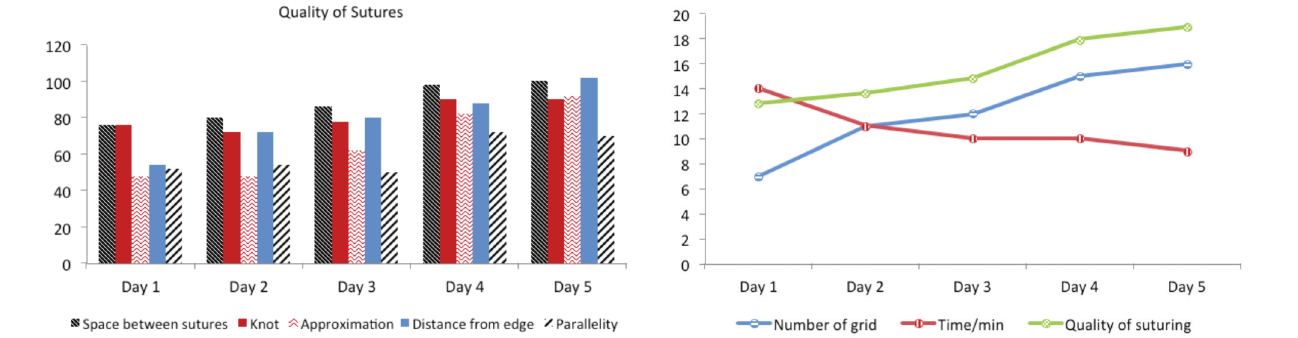
Correlation between microgrids, time (min) and quality Fig. 4: of suturing technique